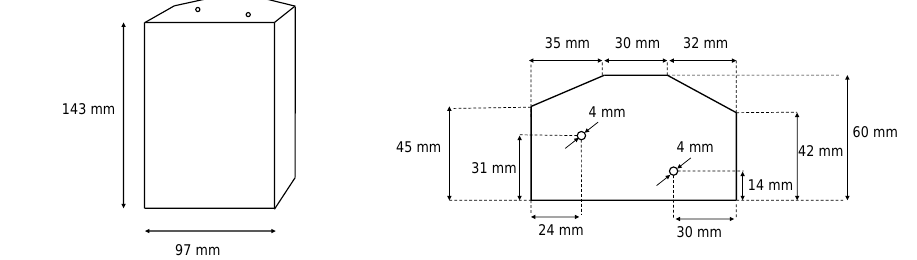
Figure 3. Sketch of the object under test and its cross section with all relevant measures.